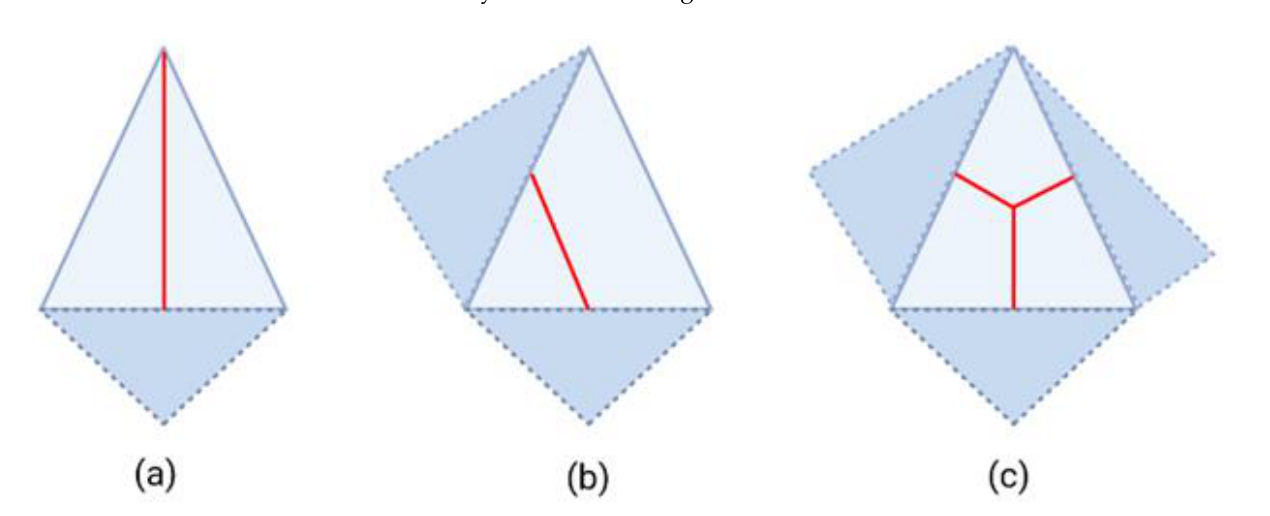
Figure 2. Triangle classification. ( a ) Type one; ( b ) type two; ( c ) type three.